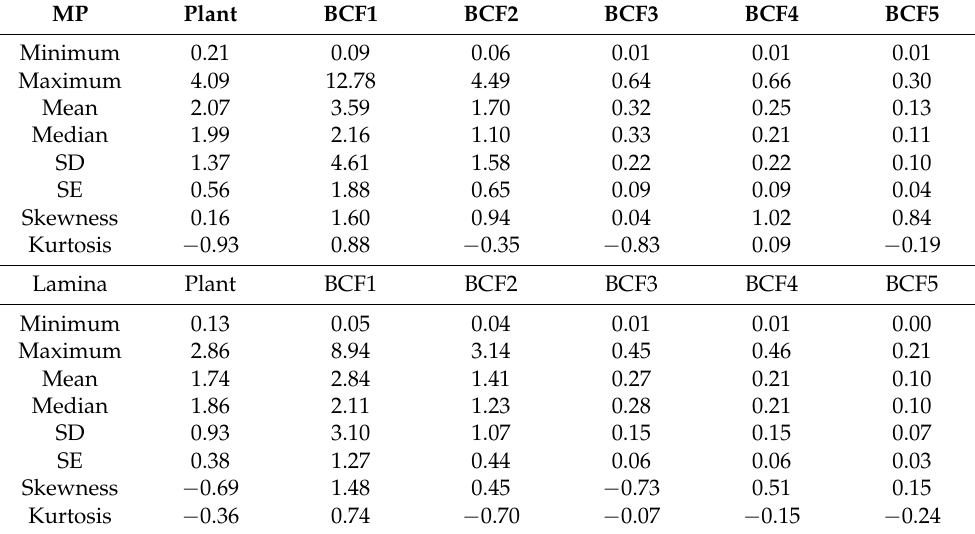
Skewness − 0.69 Kurtosis − 0.36 0.74 − 0.70 − 0.07 − 0.15 −